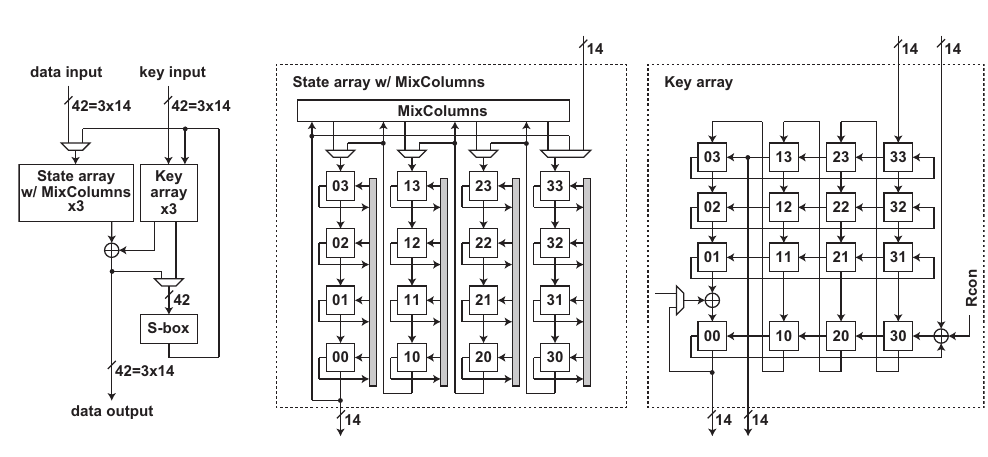
Figure 9: AES circuit using the proposed S-box